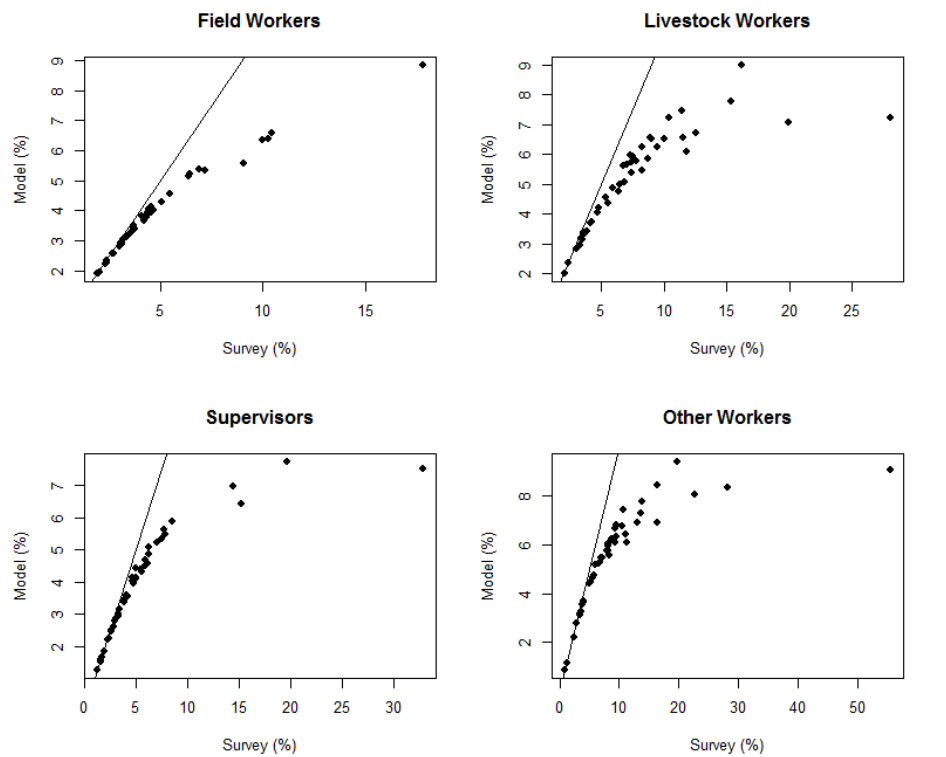
Figure 10. Coefficients of variation (%) for state-level model and survey estimates of average hours per week by worker type.